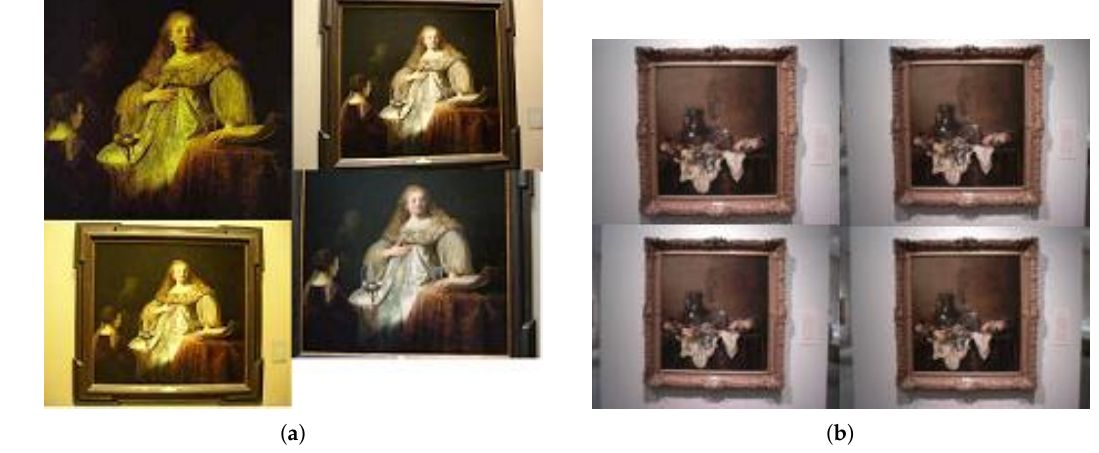
Figure 3. In ( a , b ) some examples of art painting are